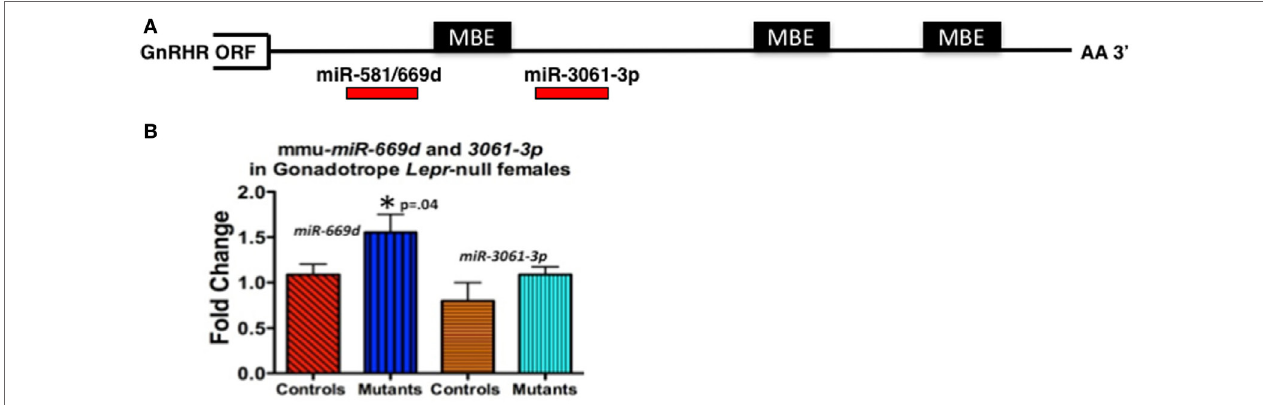
FiGUre 4 | (a) Candidate regulatory elements within the murine Gnrhr 3 ′ -untranslated region (UTR) include MBEs and at least two miRNA target sites. In silico analyses (TargetScan 7.1, ENSMUST00000031172.8) indicate three consensus MSI binding sites or elements (MBEs) and 16 miRNAs target sites (only 2 shown) within the murine GnRHR 3 ′ UTR (182 nucleotides). The relative positions of the three MBEs and two miRNAs ( miR-581/669d and miR-3061-3p ) are shown schematically. The MBE closest to the open-reading frame (ORF) is flanked by sequences encoding miR-581/669d and miR-3061-3p . (B) miR-581/669d and miR-3061-3p levels in Lepr- null gonadotropes. Total RNA enriched for miRNA was isolated from whole pituitaries of control and gonadotrope- LeprEx17- null females using the Maxwell miRNA tissue kit (Promega, AS1470). We used the TaqMan MicroRNA Reverse Transcription Kit (Applied Biosystems, 4366596) with TaqMan small RNA assays to amplify our miRNAs of interest. We performed qRT-PCR using the TaqMan small RNA qPCR primers with the TaqMan Universal PCR Master Mix II (Applied Biosystems, 4440038) in triplicate. We used the protocol provided with the master mix and performed the experiment using a QuantStudio 12k Flex (Applied Biosystems) and the protocol provided with the master mix. Real-time PCR showed miR-581/669d elevated in the absence of leptin signaling, which is consistent with a role for this miRNA as a repressor of Gnrhr mRNA translation. *Significantly different from controls by Student’s t